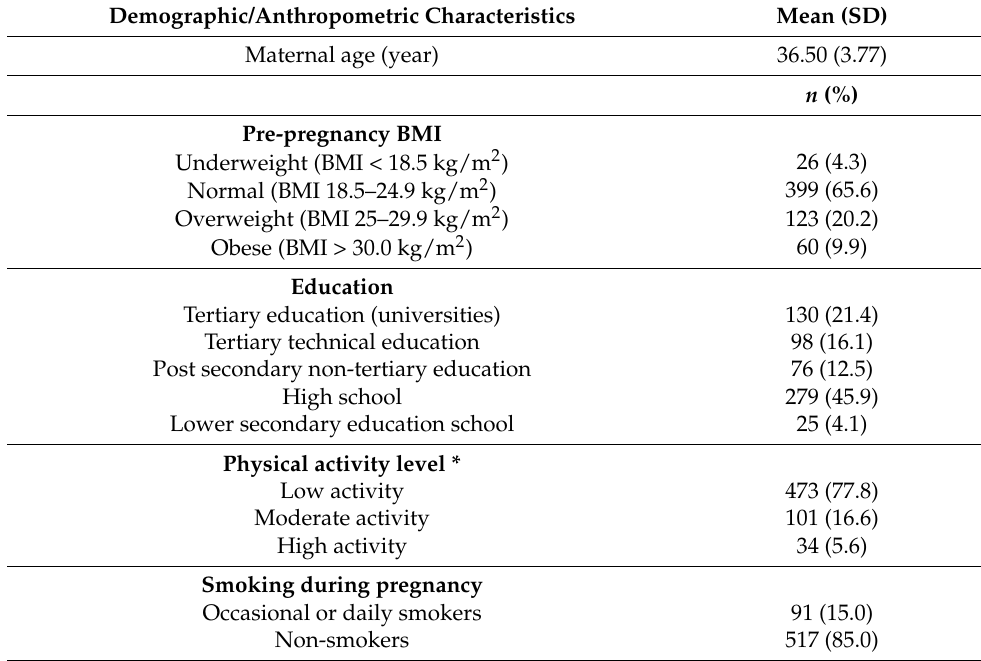
Table 2. General characteristics of the 608 pregnant